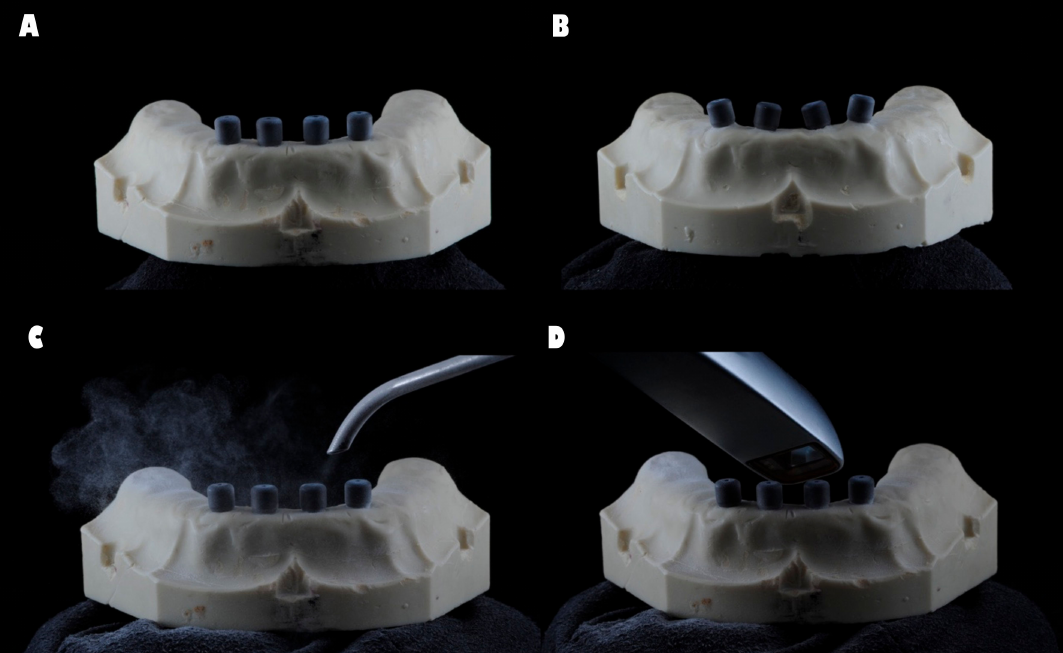
Figure 1. ( A ) Master model parallel scanbodies; ( B ) master model non-parallel scanbodies; ( C )